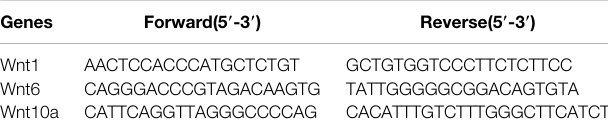
TABLE 2 | Sense and antisense primers for ChIP real-time PCR.